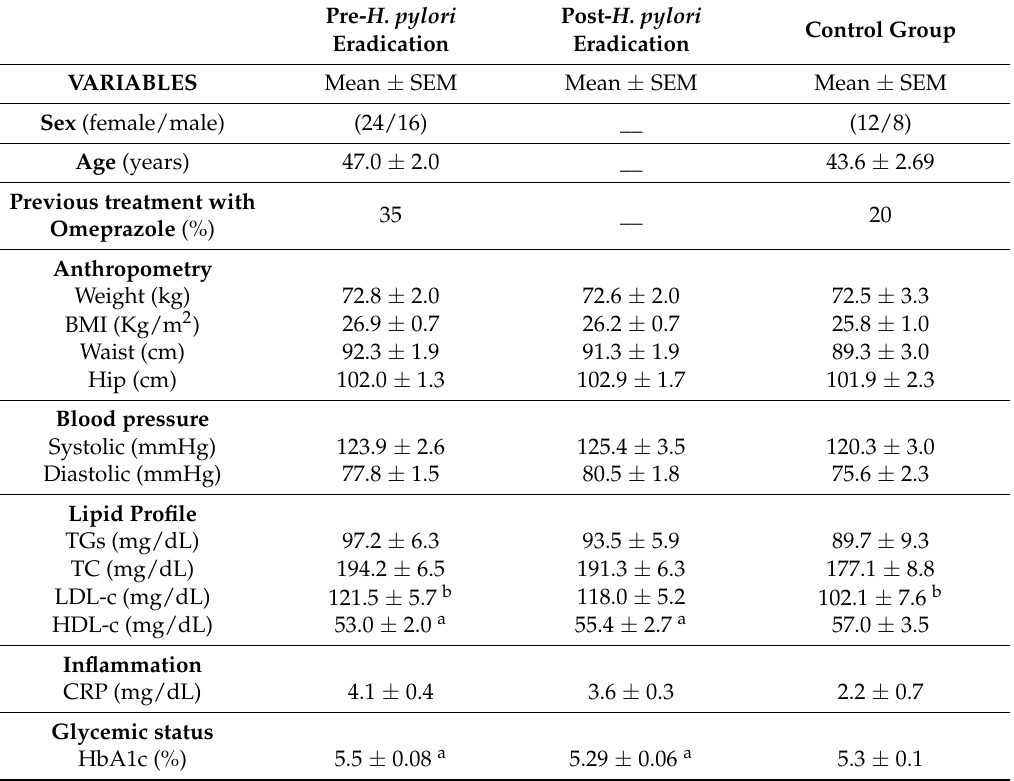
Table 1. Anthropometric and analytical characteristics of the study